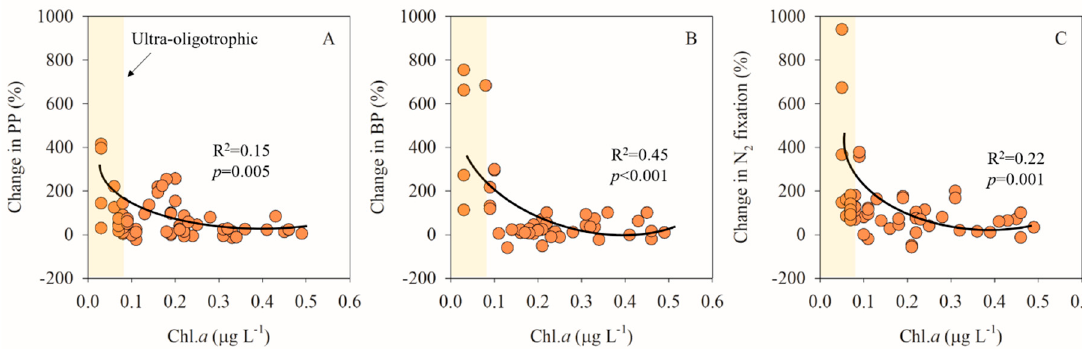
Figure 6 . Relationship between Chl. a and % change in ( A ) PP, ( B ) BP, and ( C ) N 2 fixation following dust amendment in different oceanic environments. Data were compiled from [12,13,16–18,77–83] and this study.